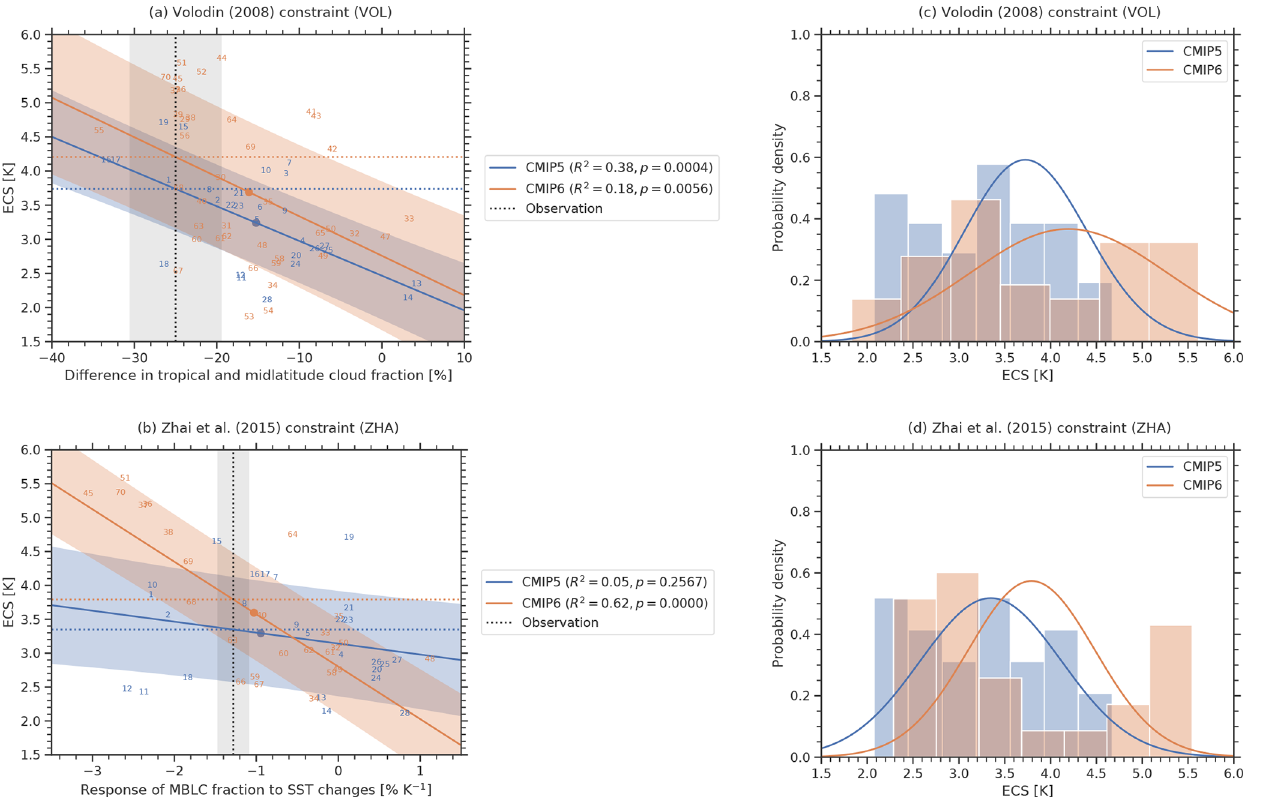
Figure 5. As in Fig. 2 but for the constraints VOL and ZHA. Table 4. Overview of the constrained ECS ranges and p values for all 11 analyzed emergent constraints. If not further specified, the un- certainty ranges correspond to the 66% confidence intervals (17%–83%). For CMIP5 and CMIP6, these are evaluated from the probability distribution given by Eq. (6) (see also the right columns of Figs. 2 to 5). Note that even though CMIP5 models were used for some con- straints in the original publications, the constrained ranges in column 2 and column 3 might differ due to the use of different models (in this paper, we use output from all CMIP models that is publicly available; see the data availability section for details). The p values describing the significance of the emergent relationships are defined as the probability to obtain an absolute correlation coefficient | r | or higher under the null hypothesis that the true underlying correlation coefficient between the predictor and ECS is zero. Smaller p values point to higher significance and vice versa (for details see Sect.